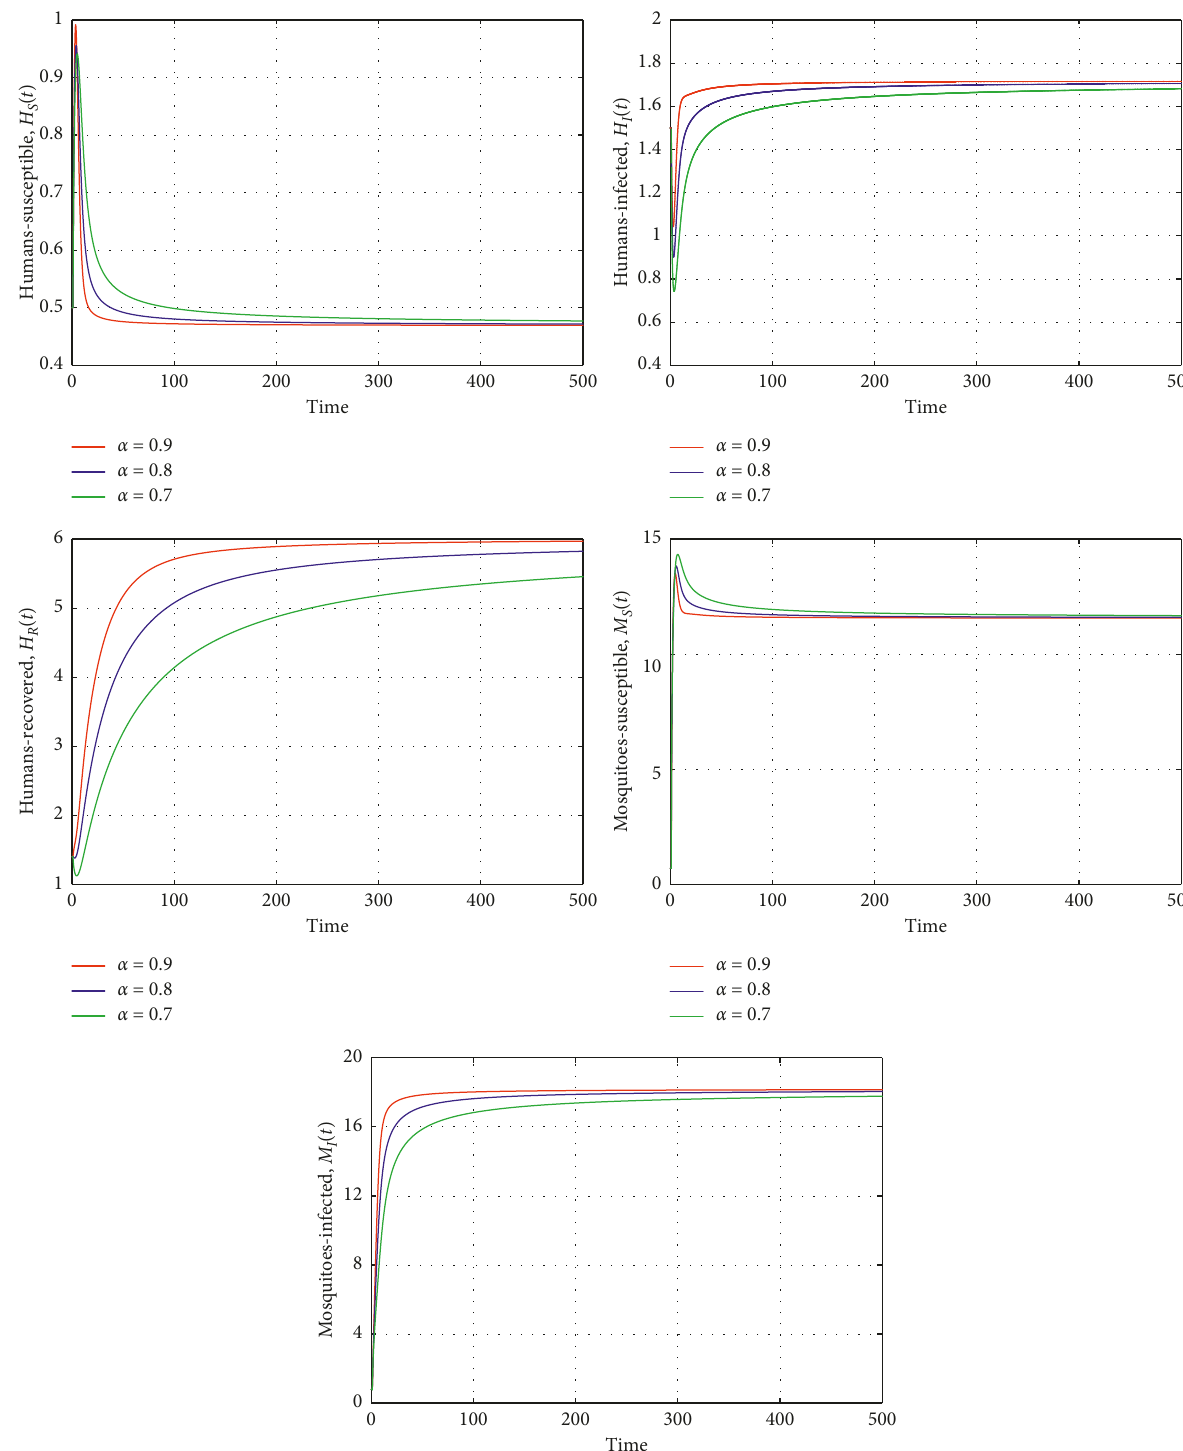
Figure 5: State trajectories of model (5) for various values of α � 0 . 9 , 0 . 8 , and 0 . 7, when τ asymptotically